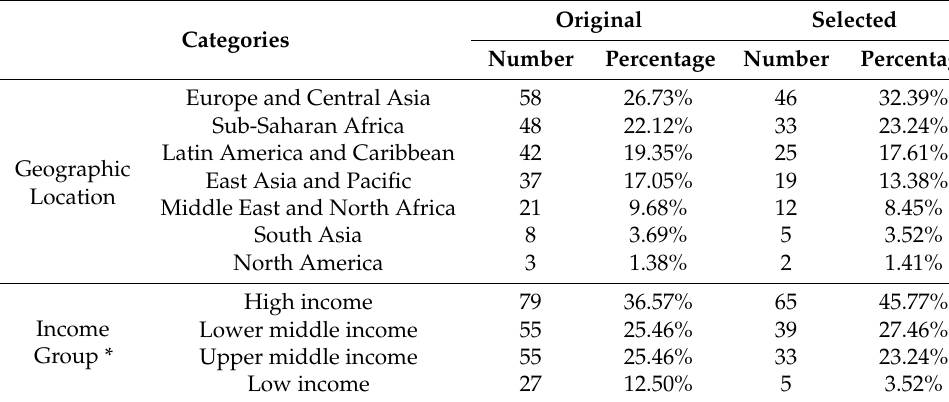
Table A2. The structure of the original and selected